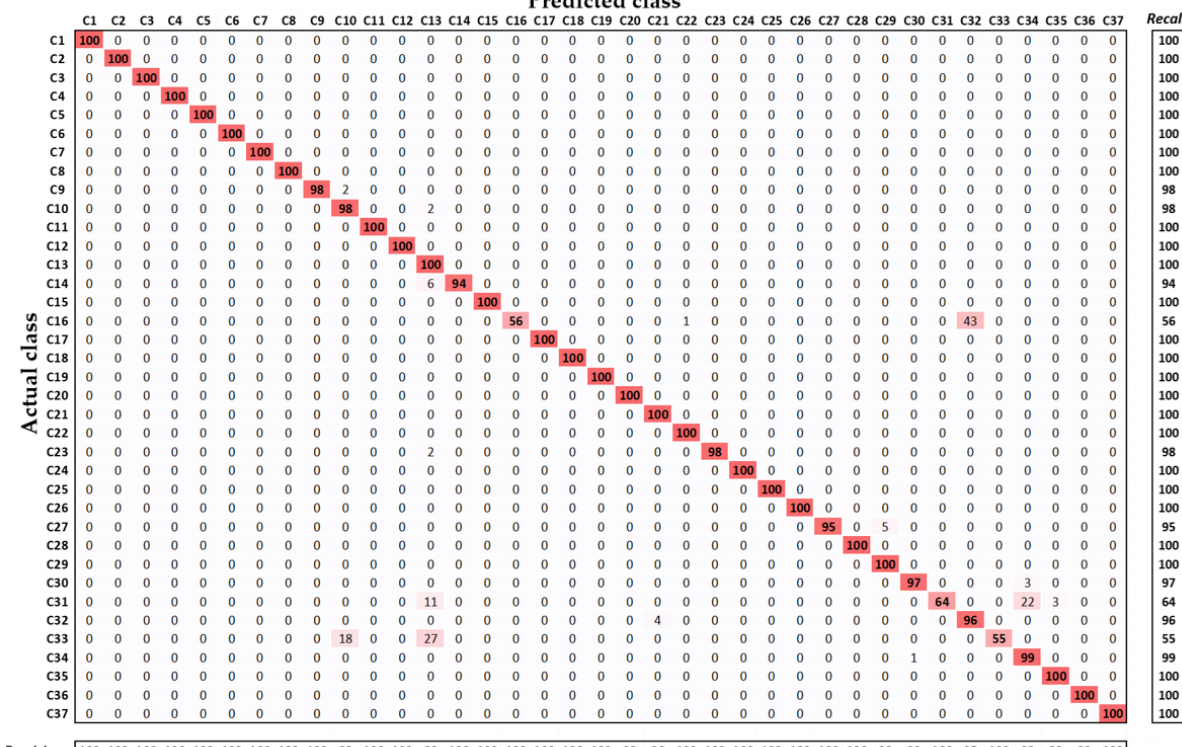
Figure 4. Detailed performance results of our proposed network shown in an average confusion